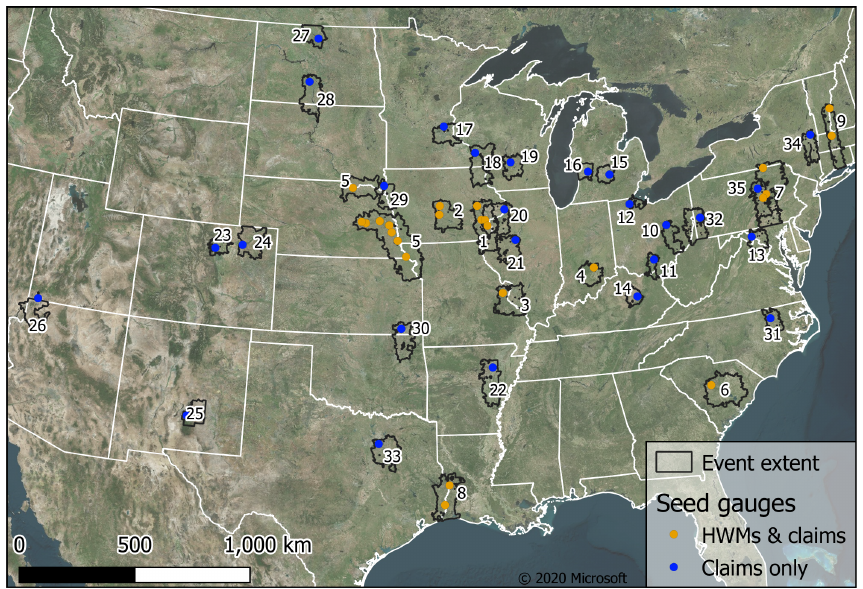
Figure 1. Geographic distribution of 35 simulated events across the contiguous US. Coloured points represent the seed gauges and the available validation data; black outlines show the discrete event boundaries and associated